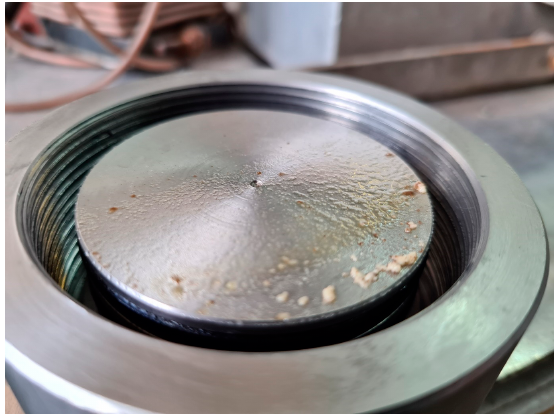
Figure 6. Extract discharge at 8 MPa, 1.2 kW US.